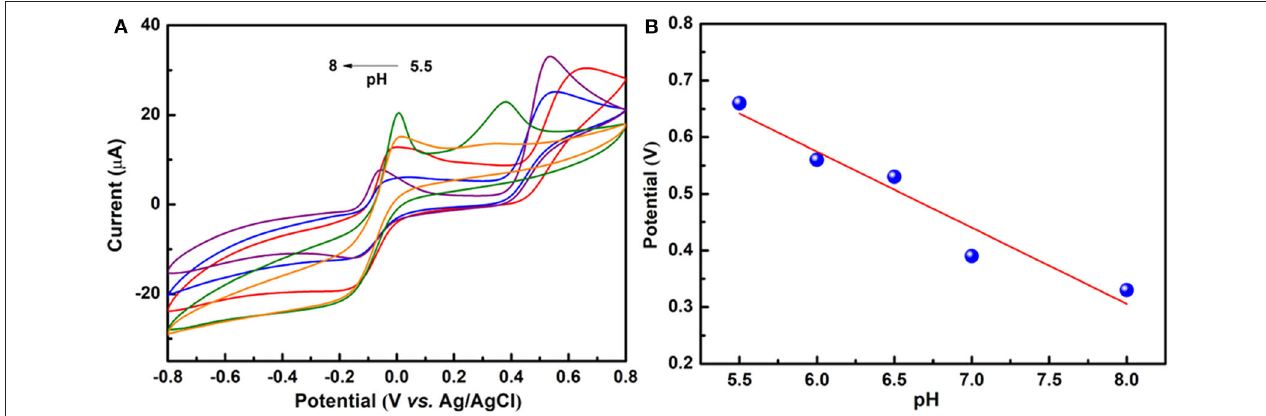
FIGURE 3 | (A) CV curves of 50 µ M paracetamol at the NiCu-CAT/GCE in 0.1M PBS under 5.5, 6, 6.5, 7, 8 pH values. (B) The relationship between pH and peak potential.